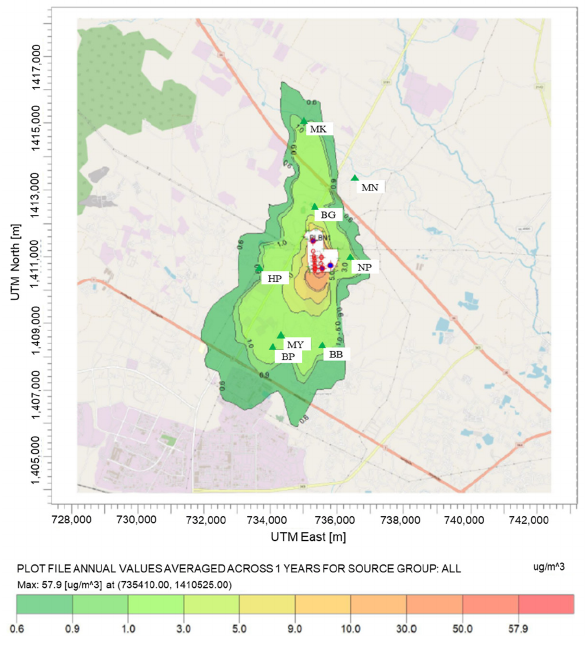
Figure 7. Spatial distribution of average annual xylene concentration.